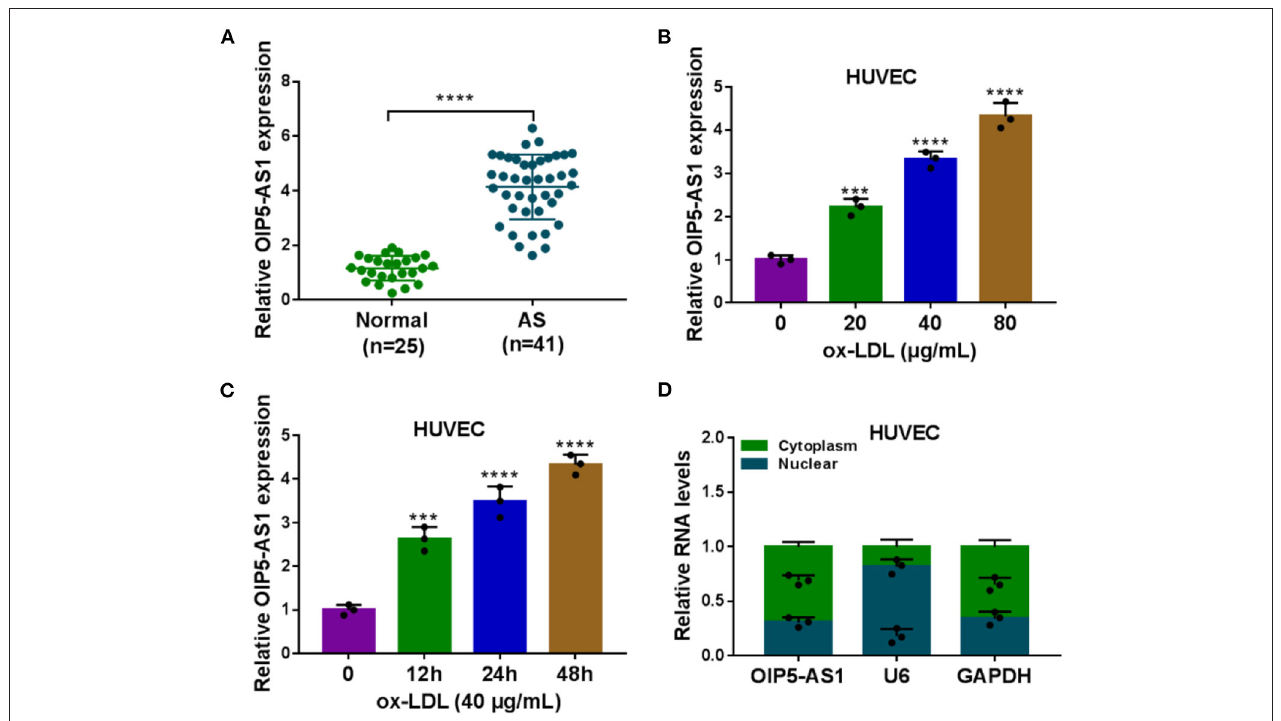
FIGURE 1 | OIP5-AS1 was highly expressed in atherosclerosis serum and ox-LDL-stimulated HUVECs. (A) Relative OIP5-AS1 expression by qRT-PCR in 41 atherosclerosis serum samples and 25 normal controls. Error bars represented SD; **** P < 0.0001 by Student’s t -test. (B,C) Relative OIP5-AS1 expression by qRT-PCR in HUVECs treated with 20, 40, and 80 µ g/mL of ox-LDL and with 40 µ g/ml of ox-LDL treatment for 12, 24, and 48h. n = 3 independent biological replicates; error bars represented SD; *** P < 0.001, **** P < 0.0001 by one-way ANOVA with Tukey’s post hoc test. (D) Subcellular localization assays in HUVECs. n = 3 independent biological replicates; error bars represented